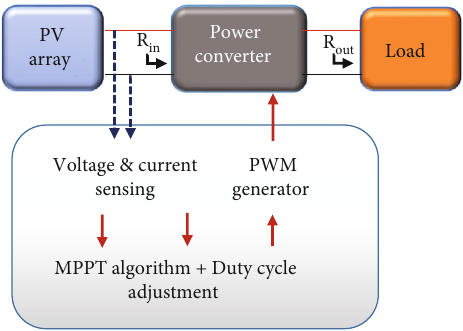
Figure 3: Schematic diagram of the complete PV